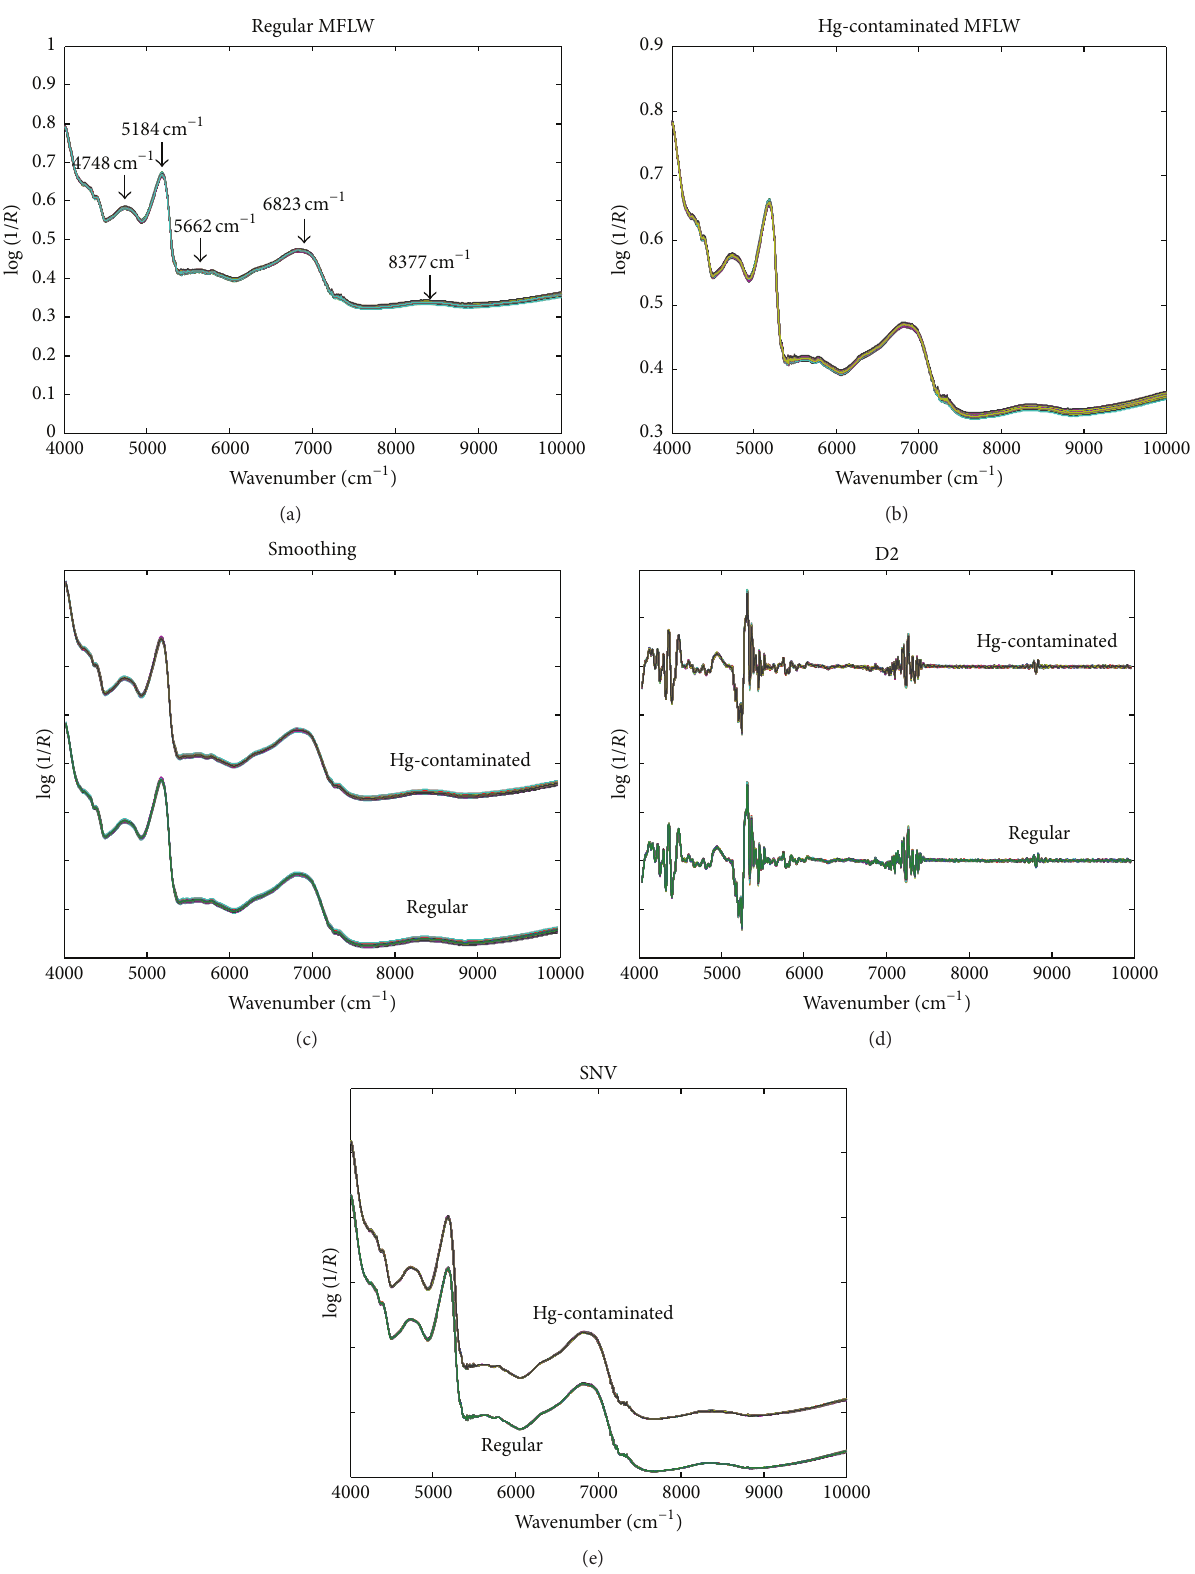
Figure 2: Some of the raw, smoothed, D2, and SNV spectra of regular and Hg-contaminated MFLW samples. An artificial shift was included to distinguish the spectra of regular and Hg-contaminated